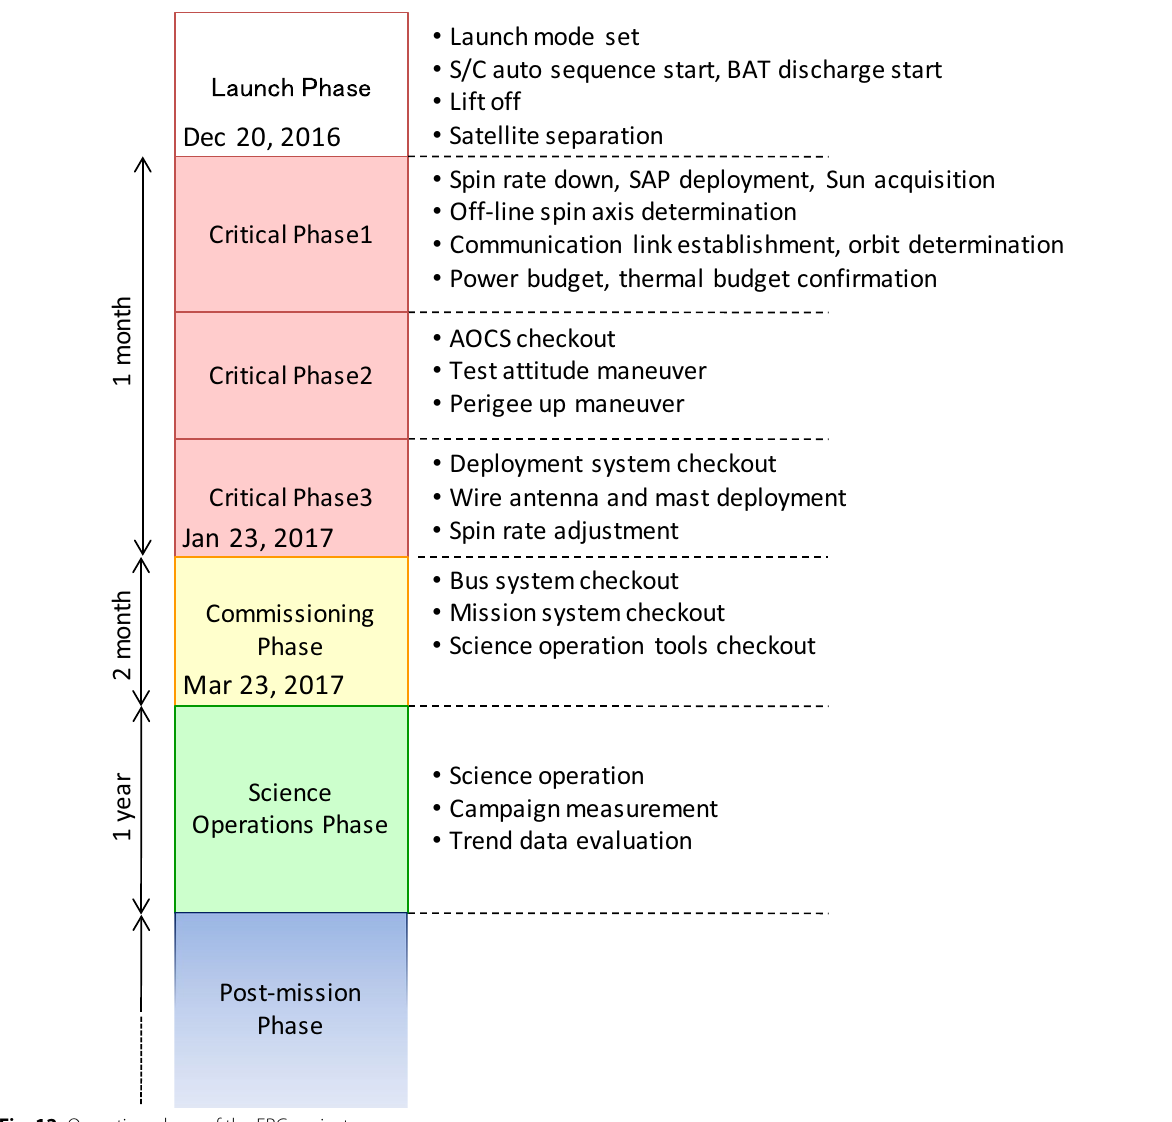
Figure 12 defines the operation phases in the ERG pro- ject, starting with the launch phase; the subsequent phases are described in the following sections.